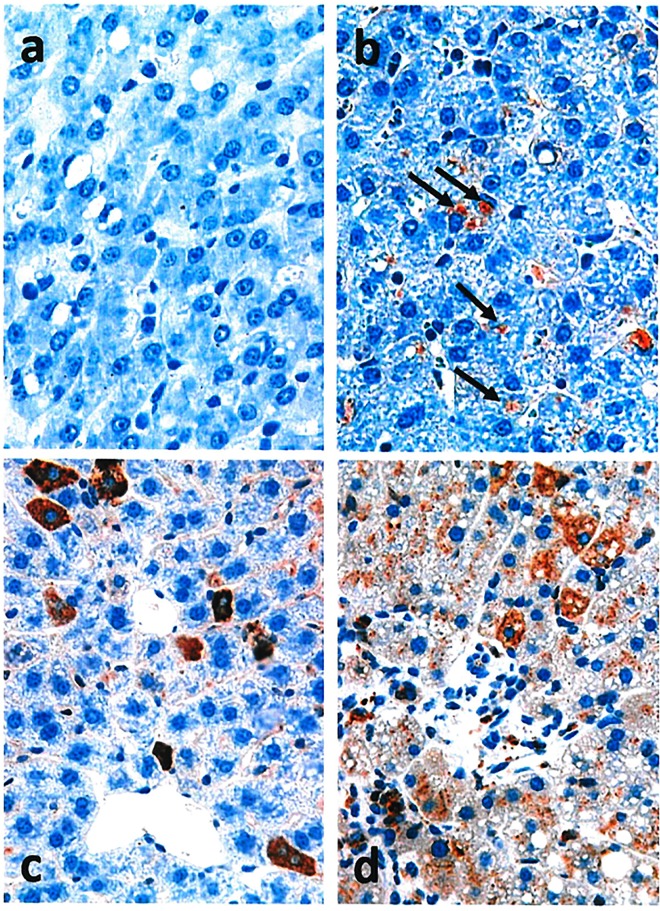
hAAT Immunohistochemistry.Non-transfected pig liver hAAT staining (a; 40x) versus transfection employing endovascular closed catheterization (b; 40x). hAAT protein staining in liver sections of transfected mice is shown (c; 40x); human liver hAAT immunostaining can be observed (d; 40x). Black arrows indicate representative specific immunohistochemical reaction against hAAT protein in pig samples. Tissue was counterstained with hematoxylin.